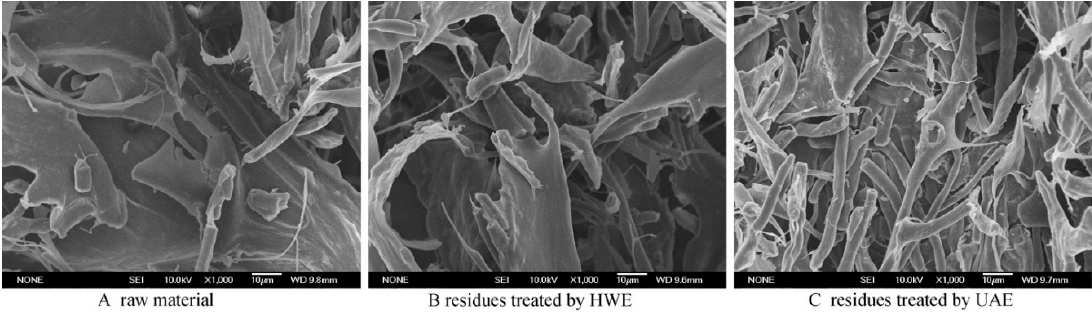
Figure 3. Scanning Electron Microscopy (SEM) images of Auricularia cornea var. Li. ( A ) raw material, ( B ) residues treated by HWE, ( C ) residues treated by UAE.